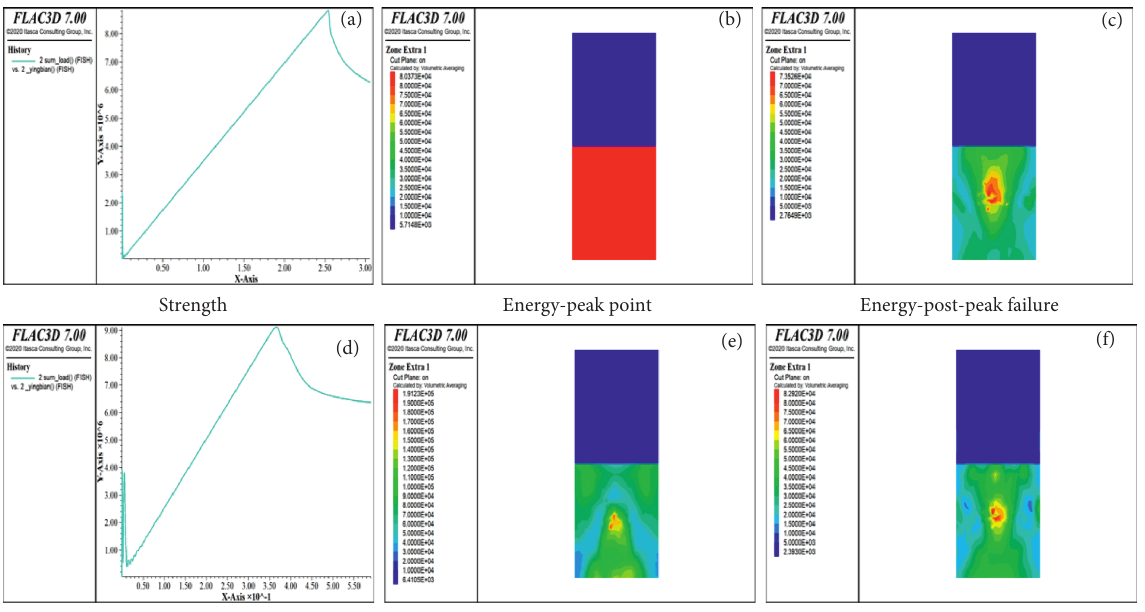
Figure 6: Comparison of strength and elastic